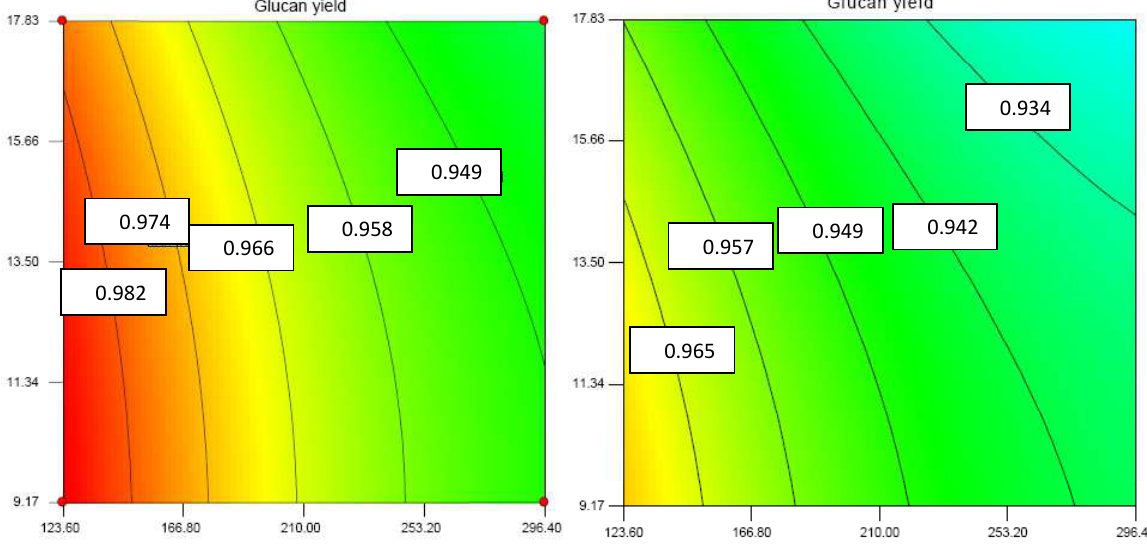
Fig.3- A, X: time (min), Y: Pressure (bar), temperature 113 0 C